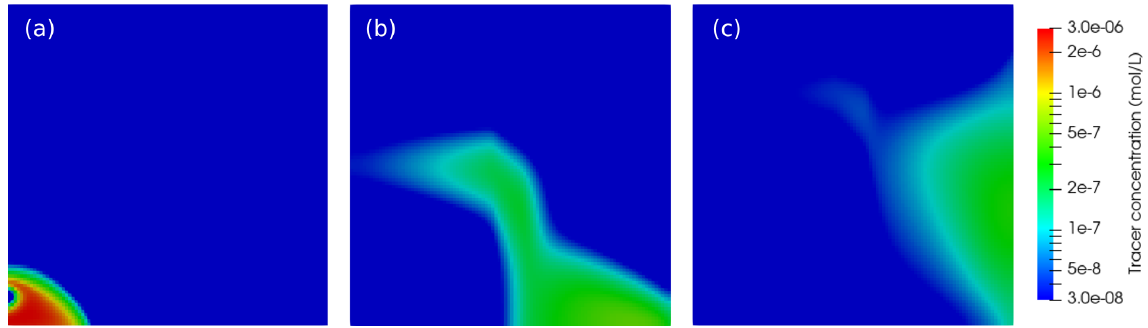
Figure 6. Spatial distribution of tracer concentration calculated with TRANSPORTSE-PHREEQC for simulation times (a) 30min, (b) 8h, and (c) 16h for Case 2 using the same log-scale mapping as in Poonoosamy et al. (2021, Fig.